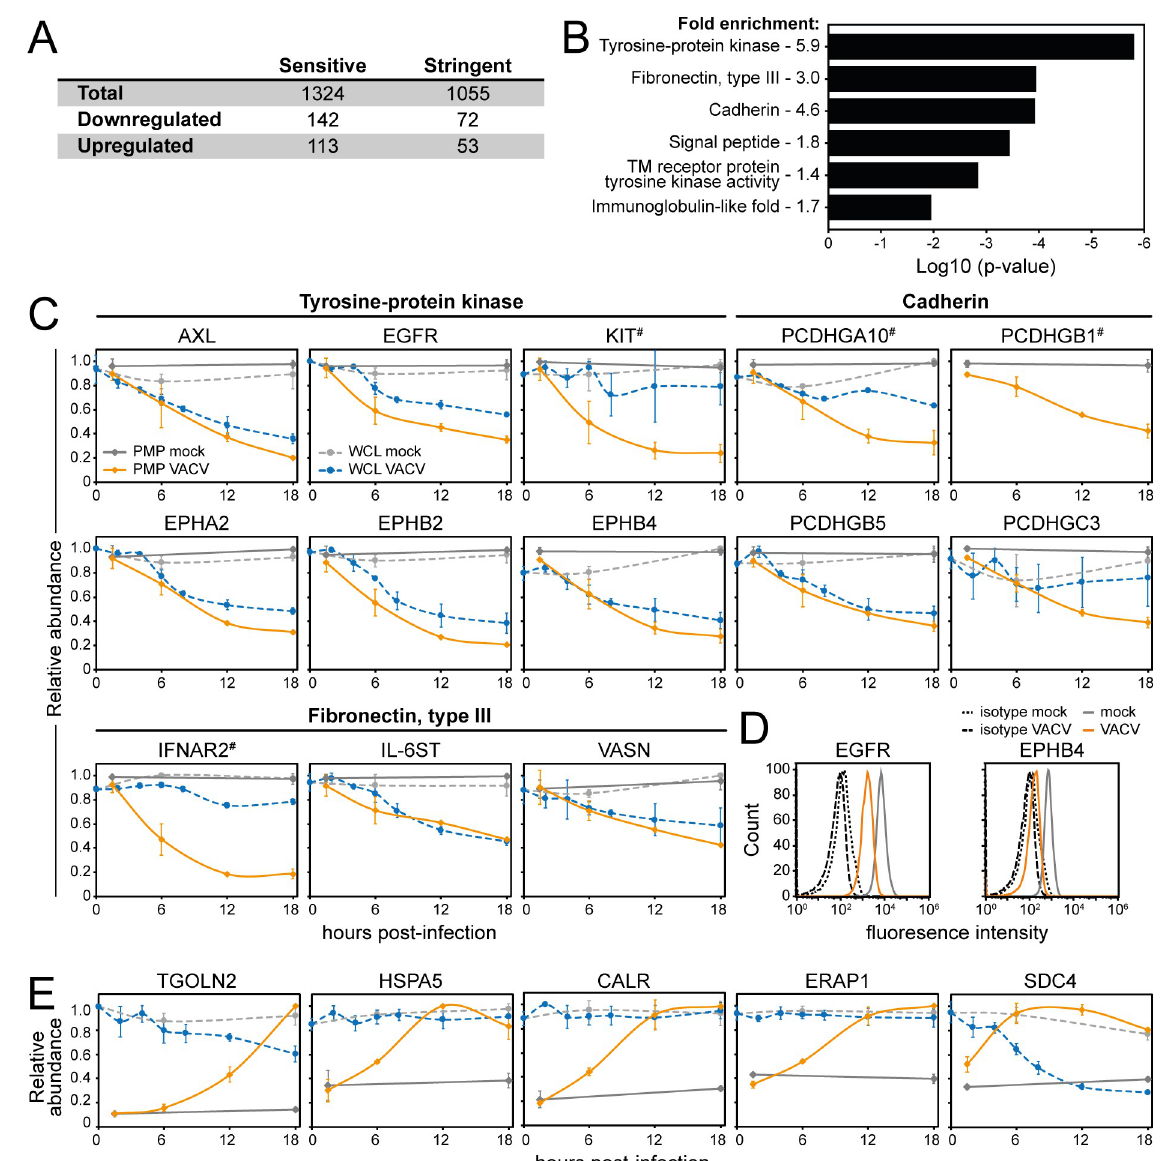
Fig 2. Selective modulation of host proteins at the cell surface during VACV infection. ( A ) Human host PM modulated according to the sensitive and stringent criteria (S2A–S2D Table). ( B ) DAVID functional enrichment of 142 proteins detected in either repeat and downregulated > 2-fold. A background of all quantified human PM proteins was used. Representative terms are shown for each cluster with a Benjamini-Hochberg-corrected p-value < 0.05 (S2E Table). ( C ) Temporal profiles of selected downregulated proteins, in which the fold- change for downregulation was in each case significant at p < 0.05 (Benjamini-Hochberg-corrected one-way ANOVA, S2A and S2C Table). For each biological repeat, the sample with the highest quantitative value was set to 1.0, and the other samples were normalised accordingly. The plots show the mean+SD of the two repeats. ( D ) Downregulation of EGFR/EPHB4 during VACV infection was confirmed by flow cytometry at 15 hpi with VACV (MOI 5). Results are representative of 3 independent experiments. ( E ) Temporal profiles of selected upregulated proteins, all with p < 0.05 (Benjamini-Hochberg-corrected one-way ANOVA, S2B and S2D Table). Data are represented as mean ± SD (PMP n = 2; WCL [9] n = 3, # WCL n < 3). proteins quantified in either or both PMP replicates showing > 2-fold change (FC) at any time-point during infection. Second, ‘stringent’ criteria included only proteins detected in both PMP replicates showing > 2 FC with a p-value < 0.05 (Benjamini-Hochberg corrected